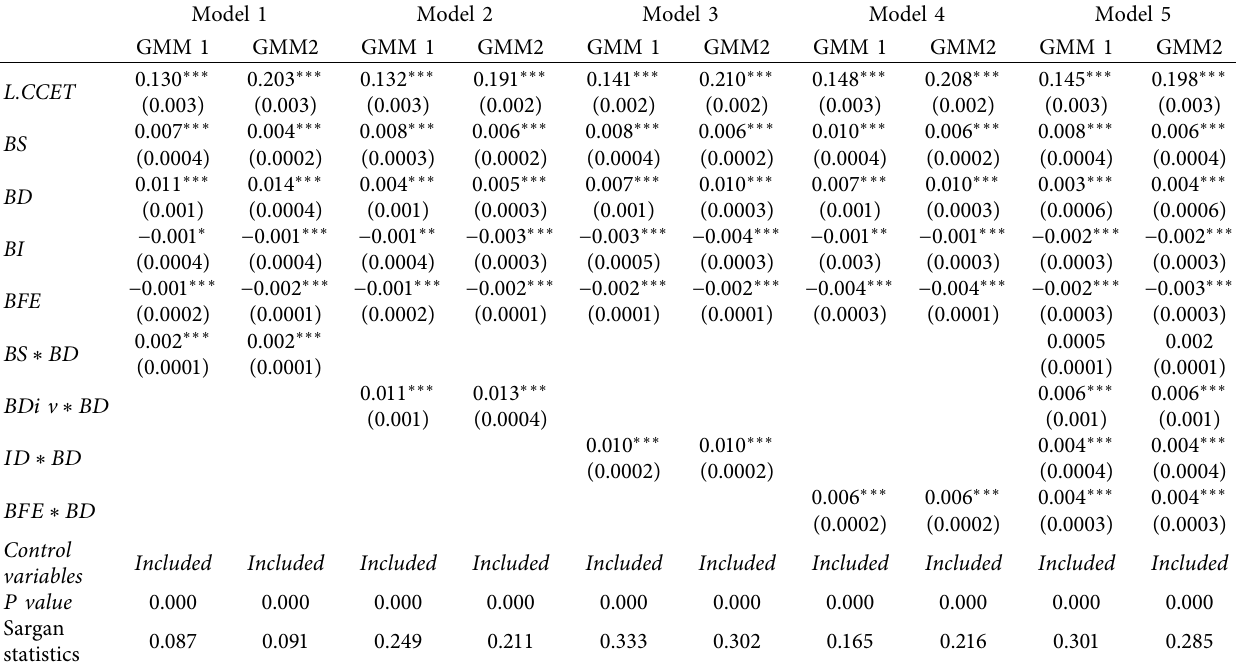
Table 6: The moderating role of multiple large shareholders on the relationship between board financial expertise and cash holding.